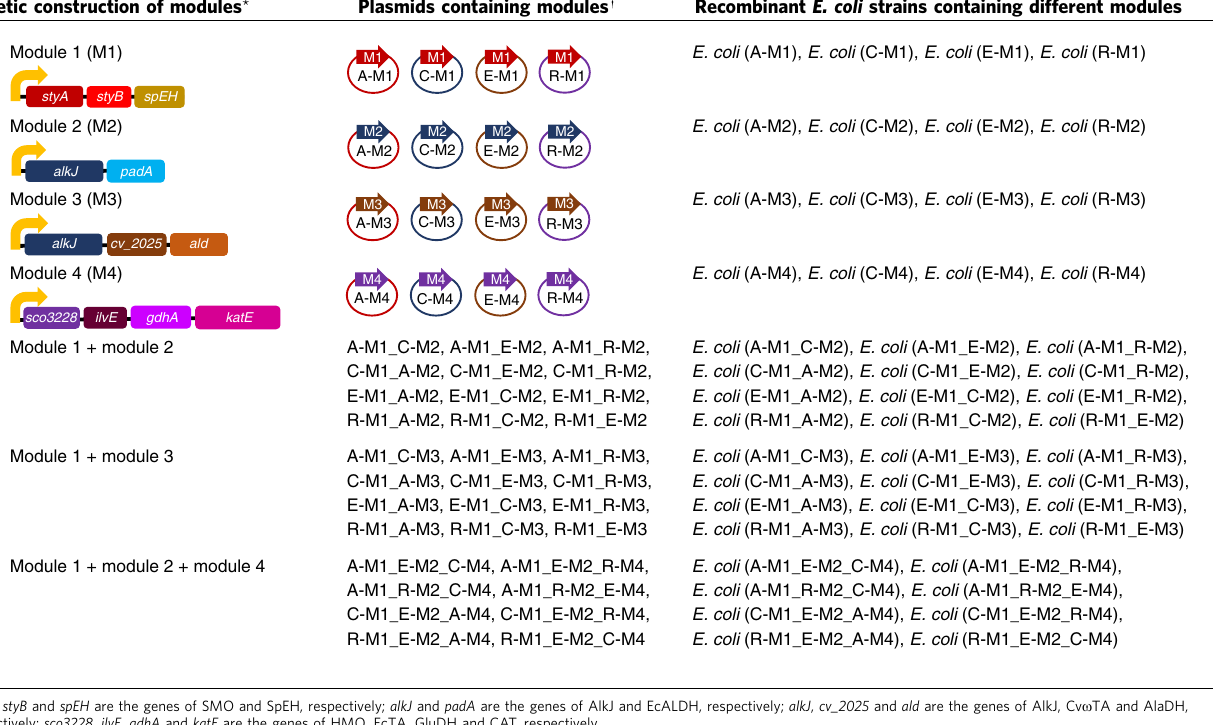
Table 1 | Genetic construction of recombinant E. coli strains containing different enzyme modules. Genetic construction of modules * Plasmids containing modules w Recombinant E. coli strains containing different